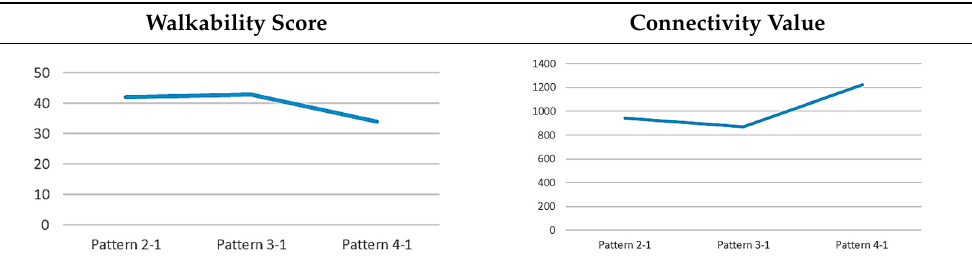
Table 6. Comparative analysis for the walkability and connectivity value.